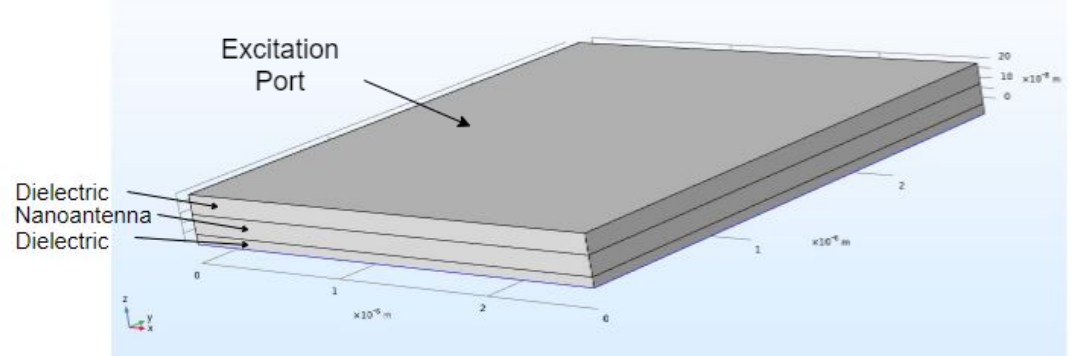
Figure 1. Simulation environment and structure illustration.